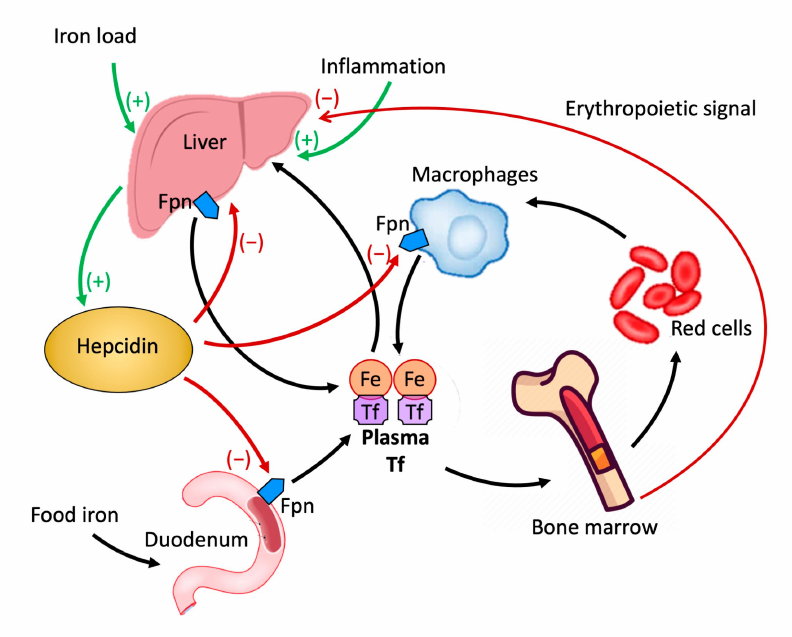
Figure 2. Role of hepcidin in the homeostasis of iron.